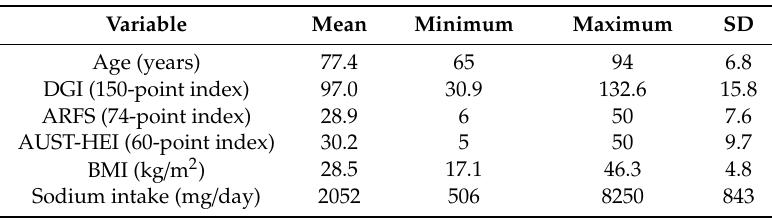
Table 1. Distribution of continuous variables.